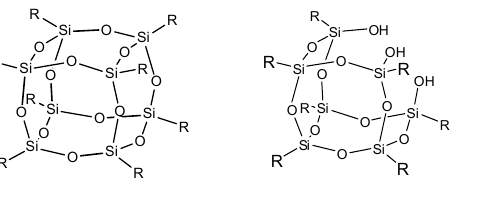
Figure 1. General structures of silsesquioxanes (SQs).